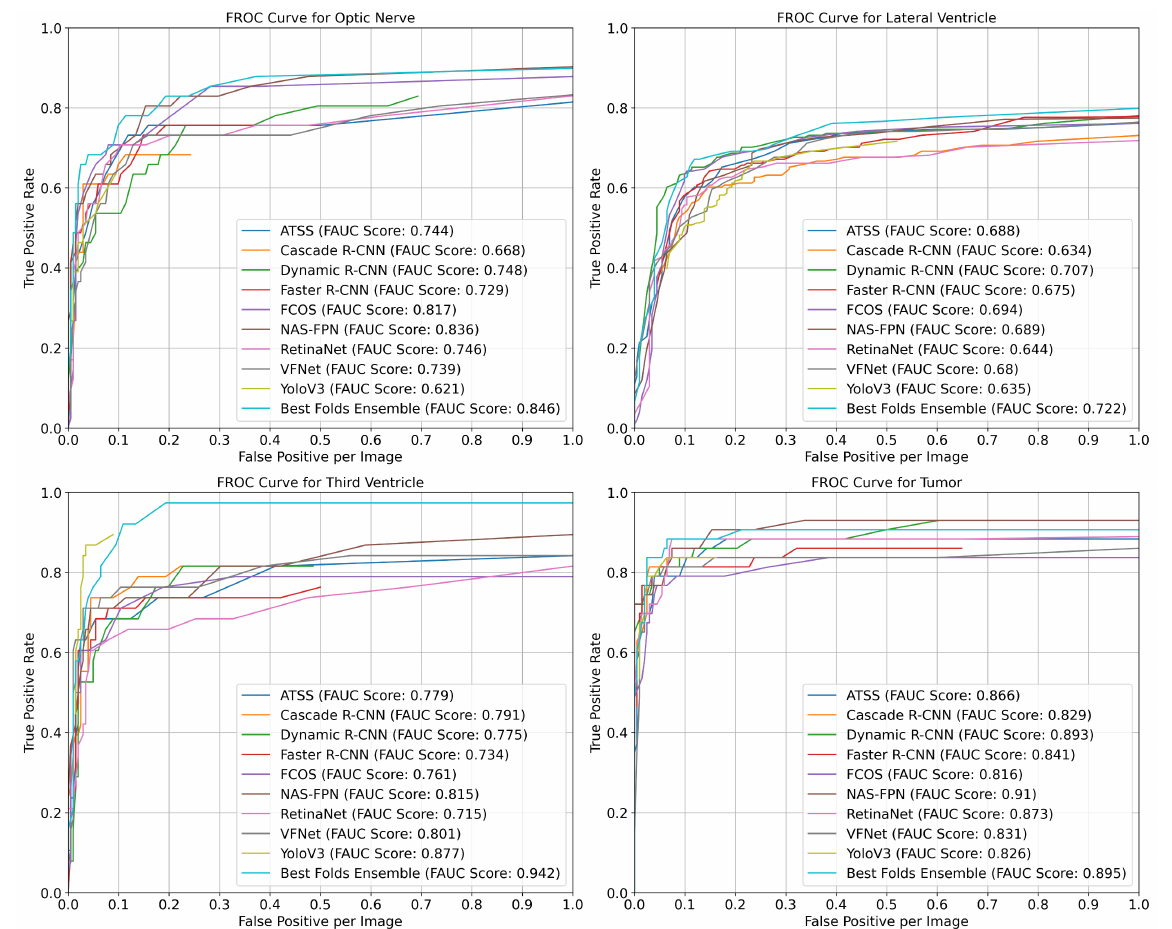
Figure 3. FROC curves based on the TPR and FPPI for each anatomical and pathological region for the best ensemble strategy and the best individual models on the Gazi Brains 2020 dataset.